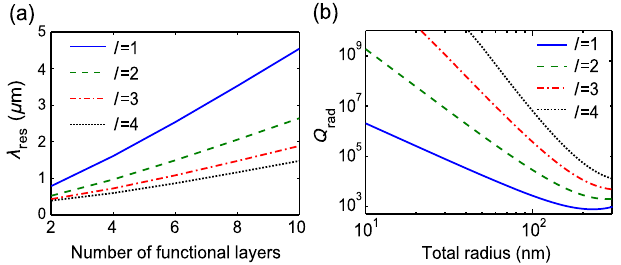
FIG. 2. (a) The maximum resonant wavelength that can be supported by a hyperbolic spherical cavity with an increasing number of functional pairs. The radius of the cavity is fixed to be 100 nm. l represents the angular momentum of the electromag- netic mode. (b) Q versus the cavity radius with a different rad angular momentum l of the electromagnetic resonance. The cavity has five functional